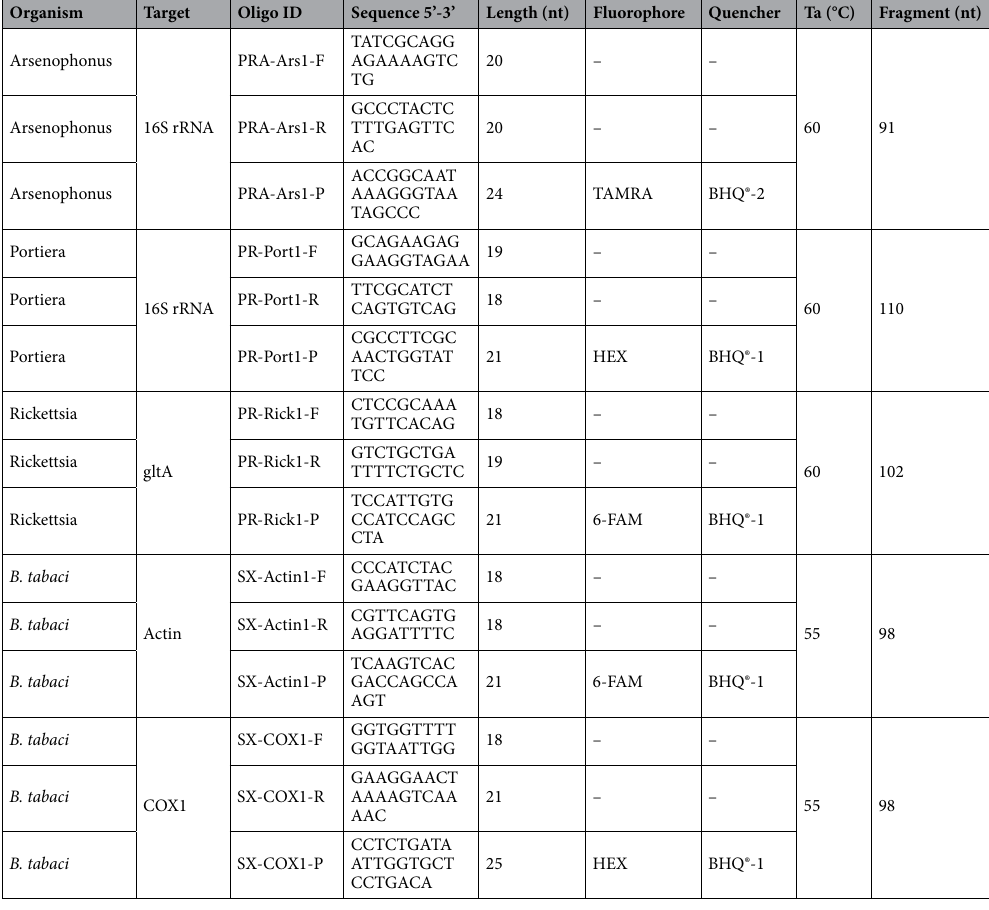
Table 2. Primers and probes used for qPCR assay with corresponding annealing/extension temperatures and amplified fragment